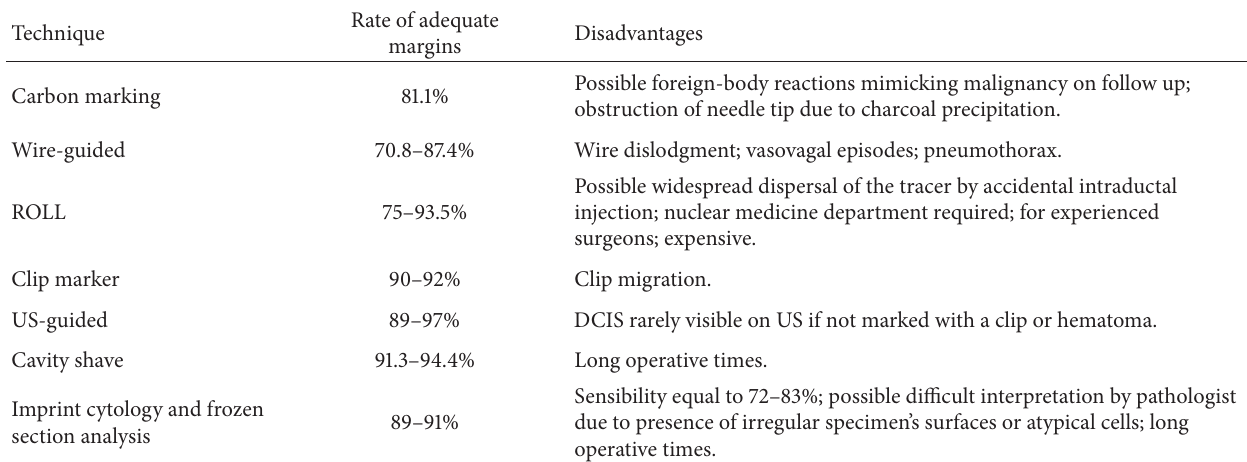
Table 3: Rates of adequate margins and main disadvantages for each